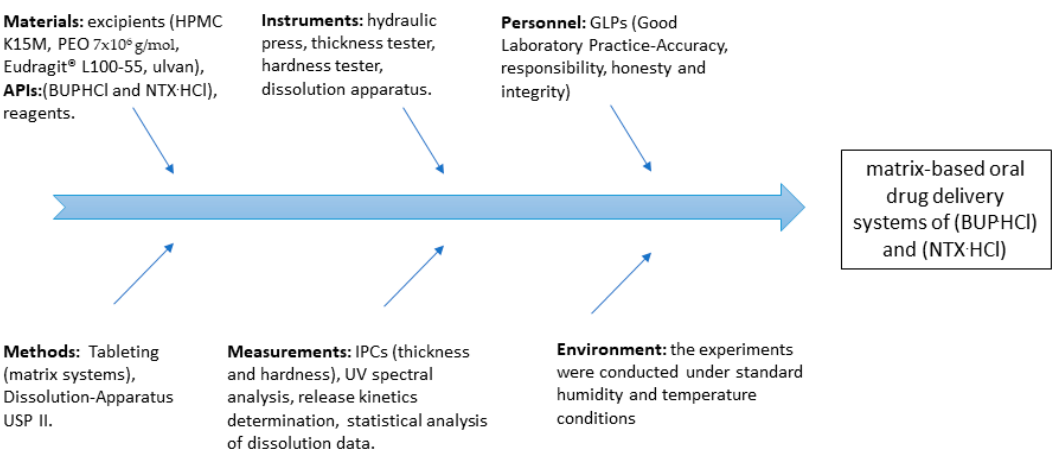
Figure 7. Ishikawa diagram: parameters that are crucial for the design and the development of matrix-based oral drug delivery systems of BUP · HCl and NTX · HCl.